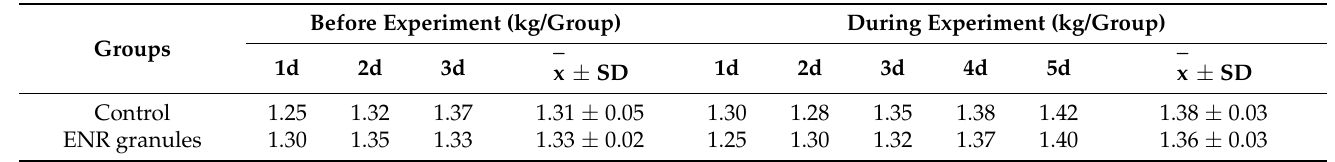
Table 1. The daily feed intake of pigs in various groups (Mean ± SD, n = 3). Groups